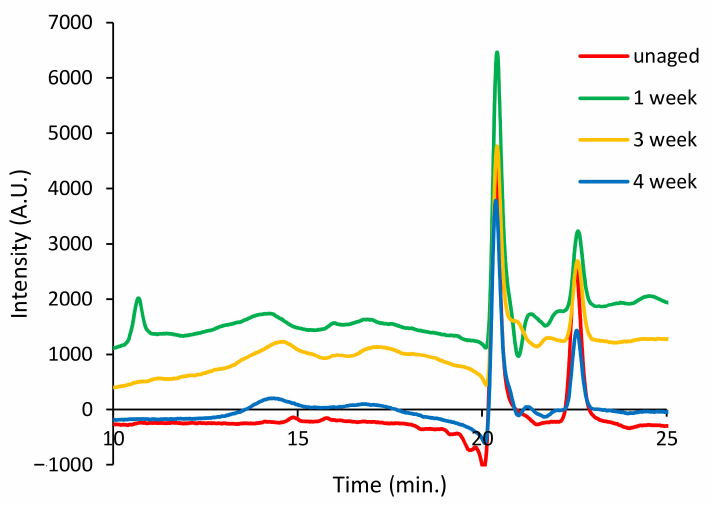
Figure 10. Size exclusion chromatography (SEC) chromatograms (10–25 min) of the DCM extracts of PP-0w (red), PP-1w (green), PP-3w (yellow), and PP-4w (blue); refractive index detector was used.